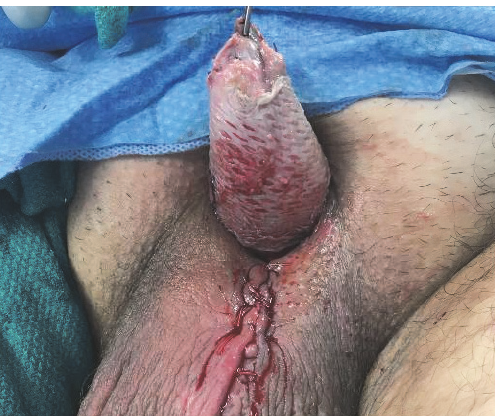
Figure7:Ventralviewofshaftfollowingplacementofsplitthickness skin